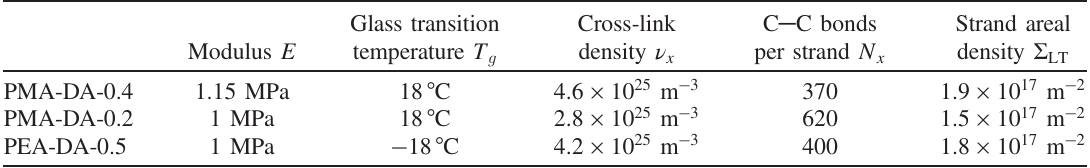
TABLE I. Sample and material parameters. PMA-DA-0.4, PMA-DA-0.2, and PEA-DA-0.5 are synthesized with 0.02 mol% of DA mechanophore and, respectively, 0.43, 0.22, and 0.5 mol% of total cross-linker. See Appendix A for details on material synthesis. The cross-link density ν Appendix